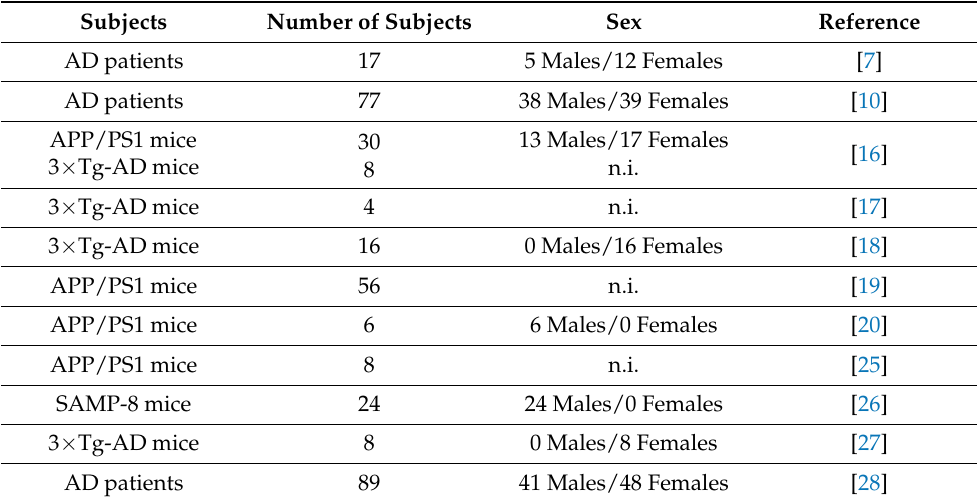
Table 1. Investigation of the SCFAs in the AD patients and in the animal models of AD. Subjects Number of Subjects Sex